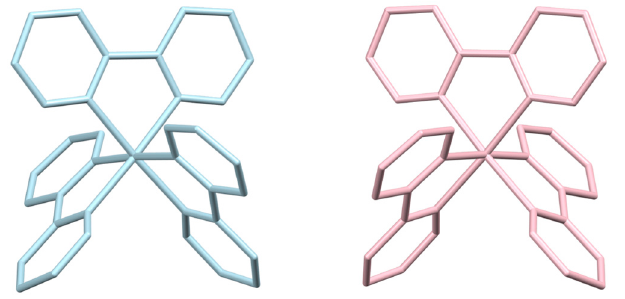
Figure 7. IUPAC recommends the notation ∆ and Λ for denoting the absolute configuration of octahedral metal complexes. The ∆ (pale blue) and Λ (pink) enantiomers of an [M(bpy) 3 ] n + complex are presented here.